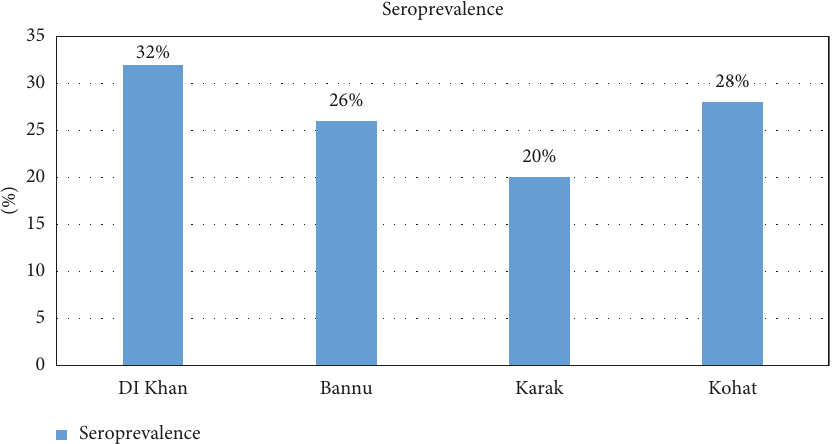
Figure 1: Graphical representation of seroprevalence on cELISA in southern areas of KPK. Table 3: Molecular identification of Mycoplasma capricolum subsp. capripneumoniae by PCR from the different clinical samples of goats in southern areas of Khyber Pakhtunkhwa, Pakistan.